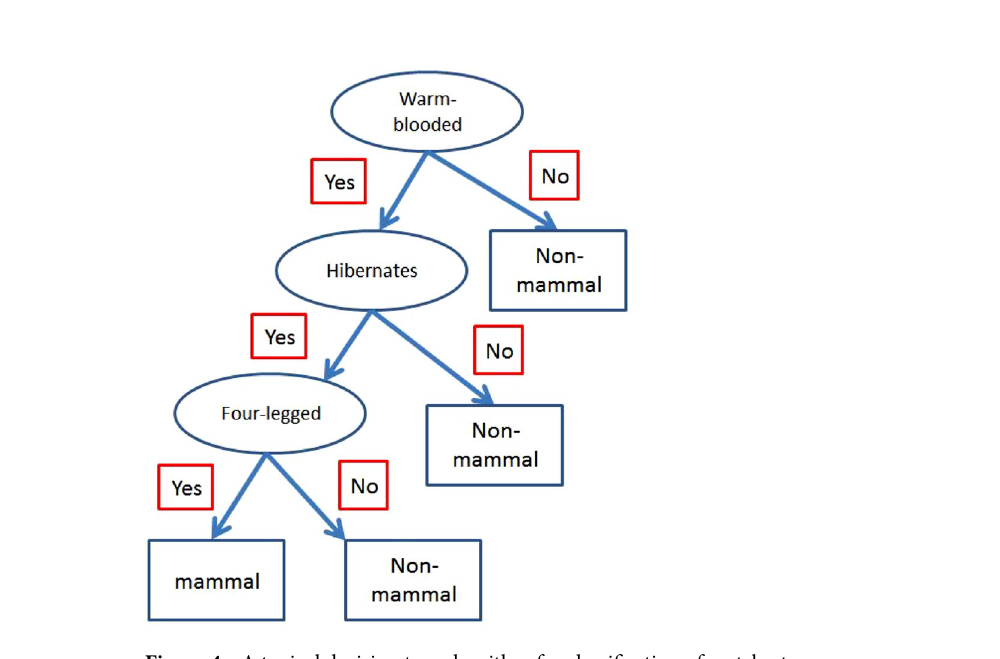
Figure 4. A typical decision tree algorithm for classification of vertebrates.